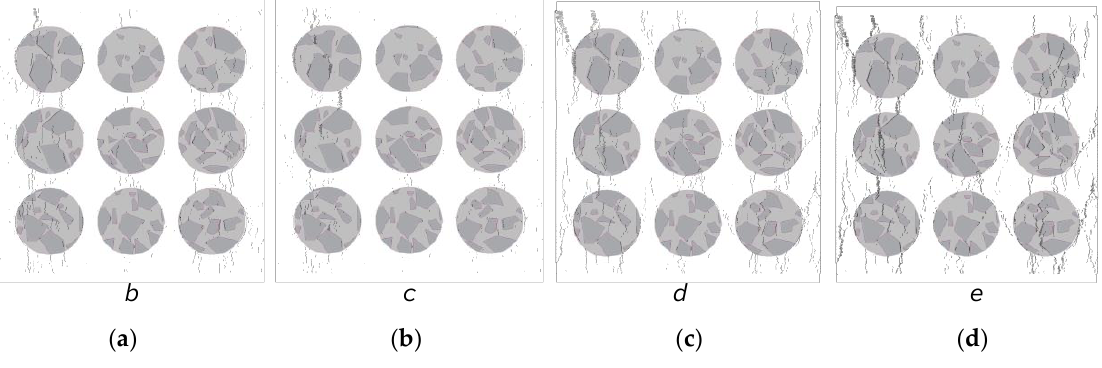
Figure 16. Tensile crack distributions at different loading stages from numerical simulation ( a ) loading stage b ; ( b ) loading stage c ; ( c ) loading stage d ; ( d ) loading stage e .